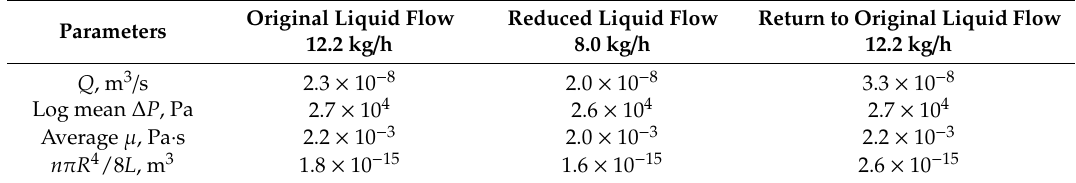
Table 6. Changes in the degree of membrane wetting when the liquid flow rate was adjusted.